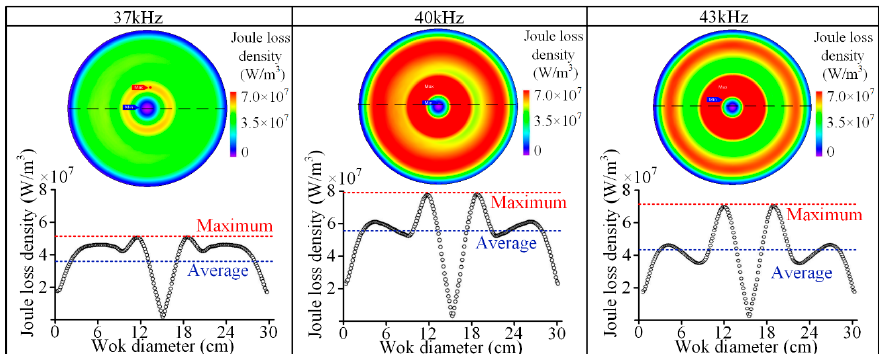
Figure 9. Eddy current density distributions in the wok. ( a ) Without frustum coil. ( b ) With frustum coil.